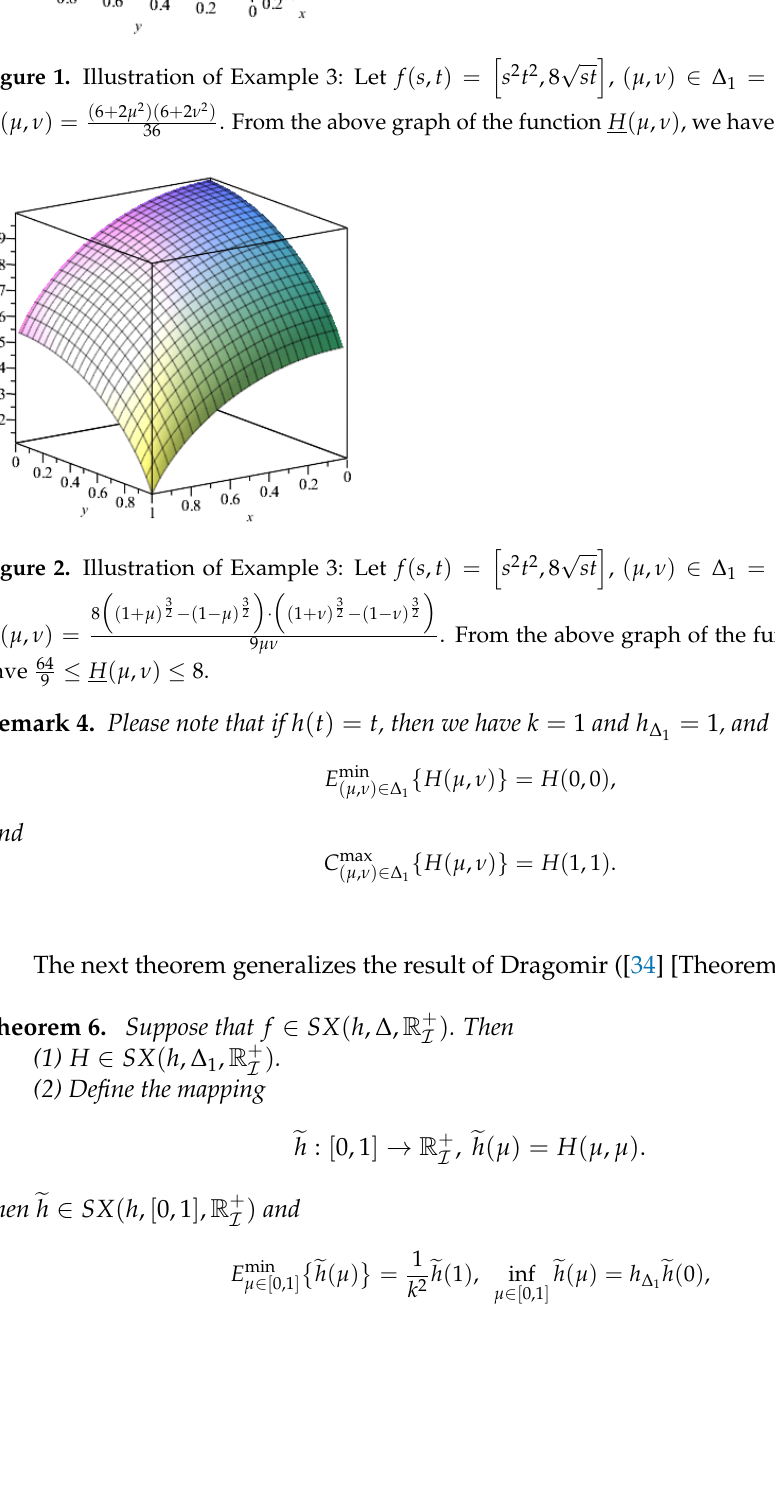
√ (cid:104) (cid:105) s 2 t 2 ,8 st , ( µ , ν ) ∈ ∆ 1 = [ 0,1 ] × [ 0,1 ] . then